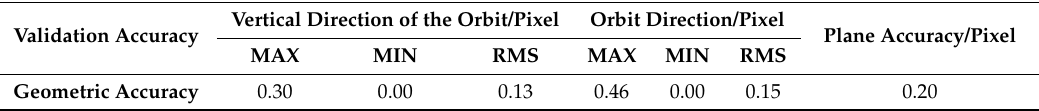
Table 4. Geometric validation